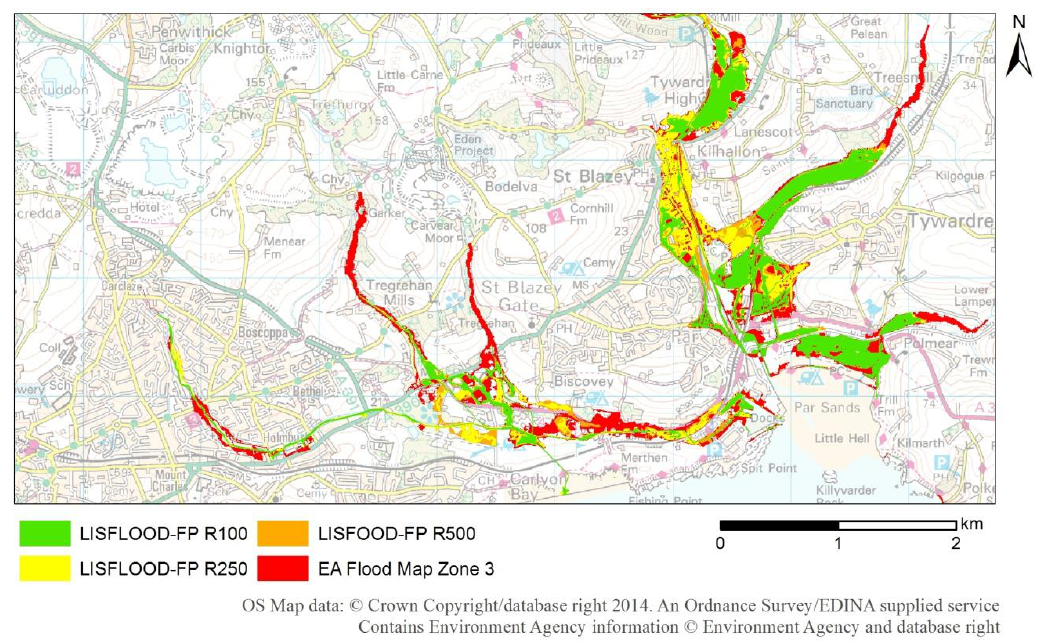
Figure 5. Comparison of LISFLOOD-FP and Environment Agency flood inundation for the selected area covering St Austell and Par within the study